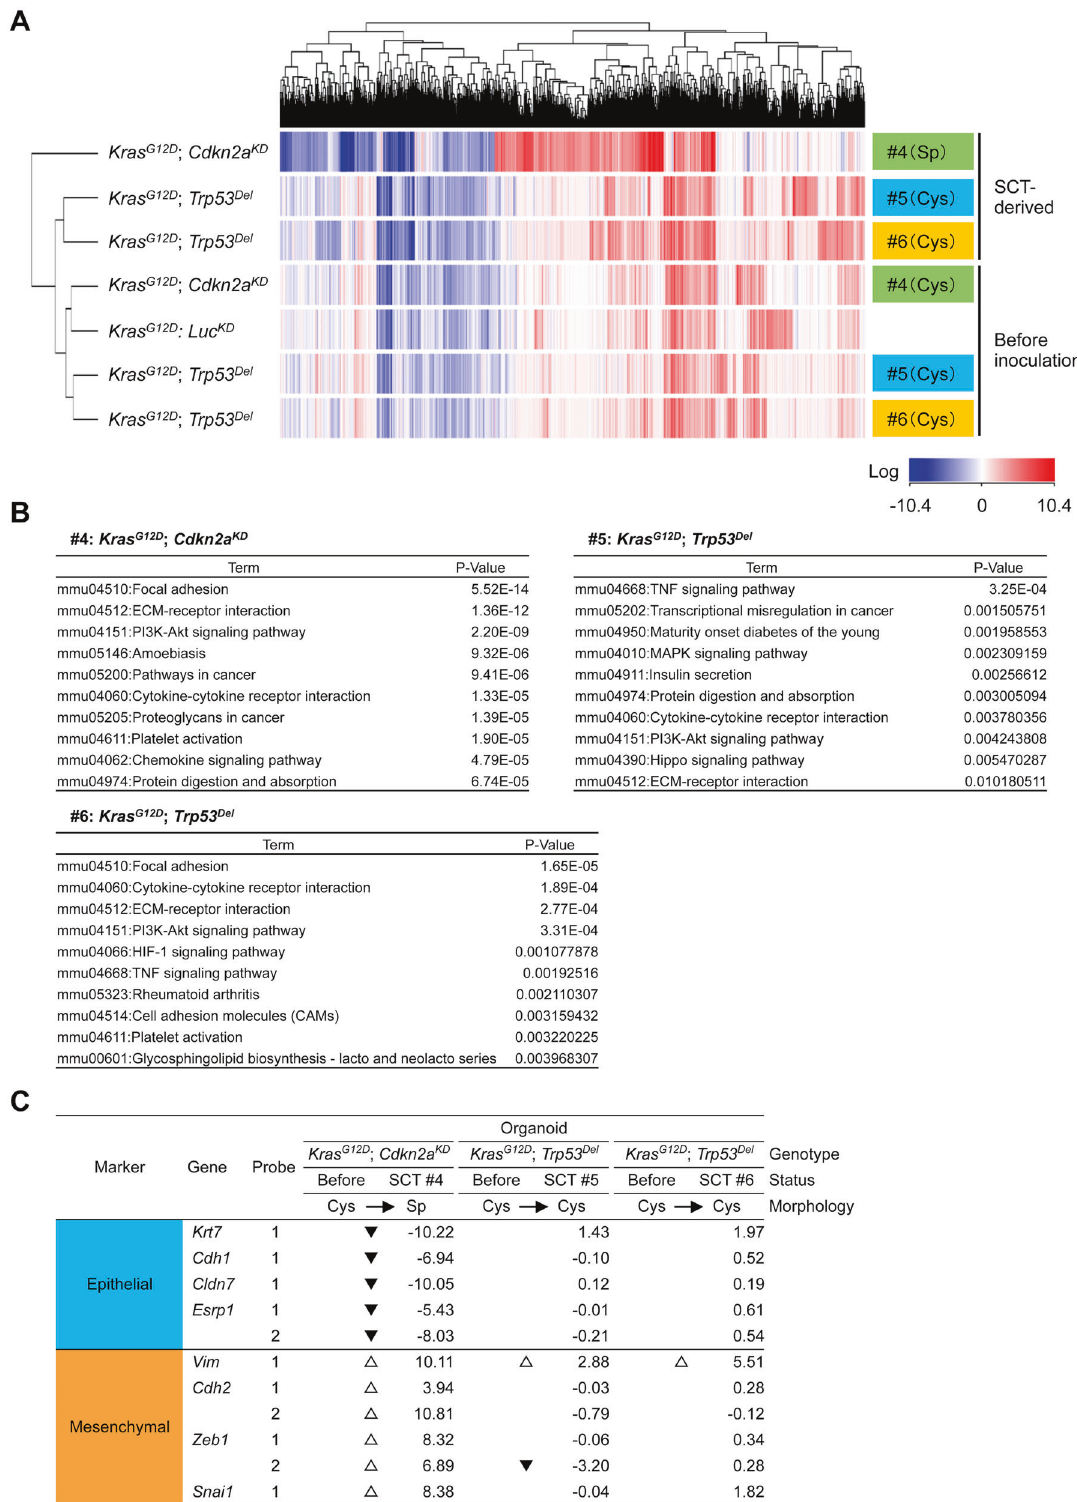
Fig. 6 Transcriptomic changes in organoids after inoculation in nude mice. A Heat map showing differentially expressed genes in transduced or tumor-derived organoids as identi fi ed by using microarray analysis. Colors range from blue to red corresponding to genes with low and high expression, respectively. B Activated function was inferred from up-regulated genes in each tumor-derived organoid. C Gene expression of epithelial – mesenchymal transition markers in tumor-derived